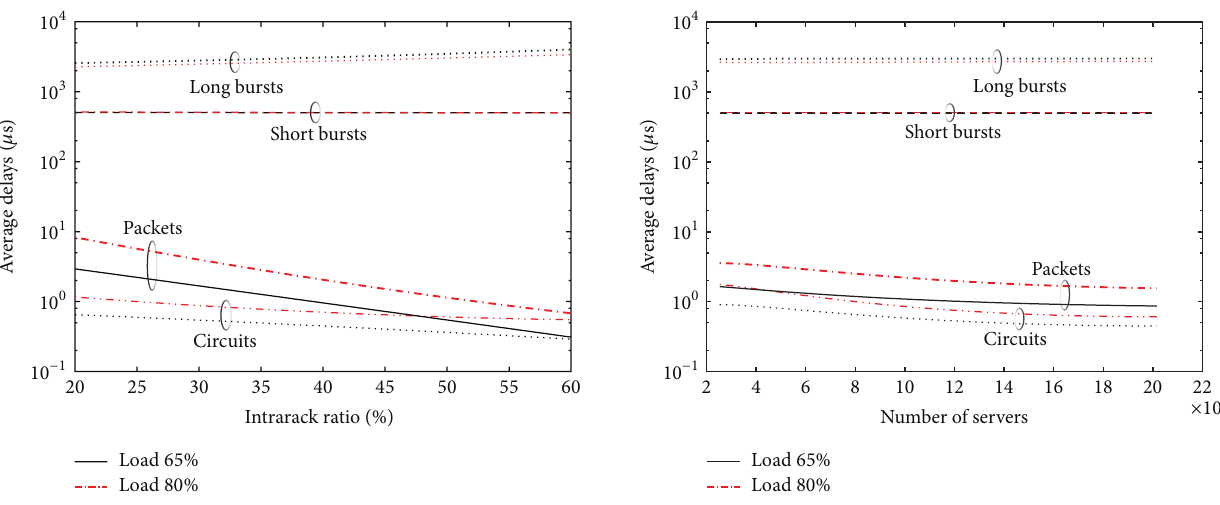
Figure 9: Average delays in the HOS network as a function of the number of servers in the data center. Two different values for the input load, namely, 65% and 80%, are considered.